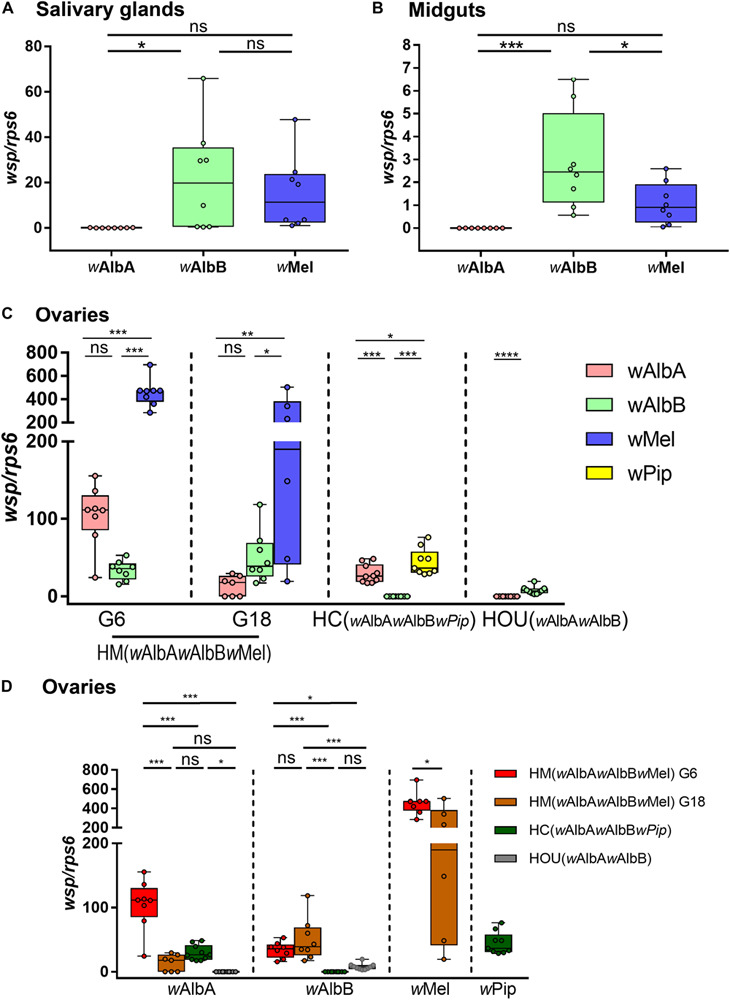
The densities of various Wolbachia strains in the salivary glands, midguts, and ovaries of HM (wAlbAwAlbBwMel) mosquitoes. The densities of wMel, wAlbA, and wAlbB in salivary glands (A) and midguts (B) of HM (wAlbAwAlbBwMel) mosquito were measured by quantitative PCR (qPCR). The densities of the three Wolbachia strains in the ovaries of HM (wAlbAwAlbBwMel) mosquitoes from two generations, G6 and G18, were compared within (C) and across (D) mosquito lines. HC (wAlbAwAlbBwPip), the transinfected Ae. albopictus line with wAlbA, wAlbB, and wPip infections. HOU (wAlbAwAlbB), the wild-type Ae. albopictus line with wAlbA and wAlbB infections. The copy number of the Wolbachia wsp gene was normalized by the mosquito rps6 gene (see Supplementary Table 2). The center of a box plot shows the median of 6–10 replicates, edges show upper and lower quartiles, and bars indicate maximum and minimum values. Dots show values from individual biological replicates. ****P < 0.0001; ***P < 0.001; **P < 0.01; *P < 0.05; ns, not significant; ANOVA and Tukey’s multiple comparisons test.